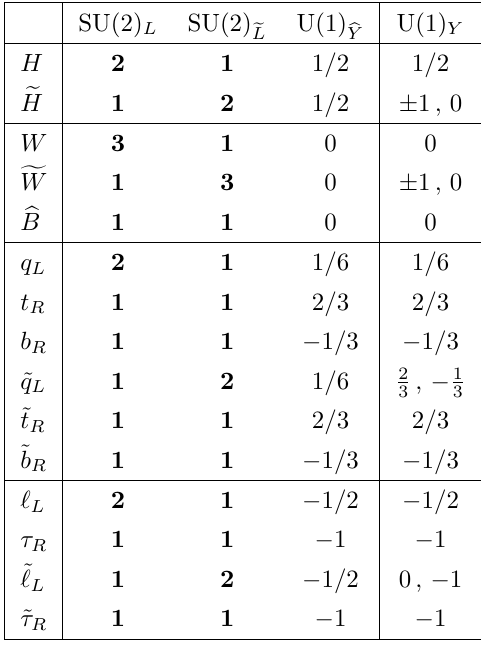
Table 1 . EW gauge quantum numbers of the SM (cid:12)elds and their twins. In the minimal scenario, with no twins for the SM W and Z , only SU(2) L (cid:2) U(1) Y are gauged and the twin low-energy content reduces to ~ t L;R and ~ ! (cid:6) ; 0 (cid:26) H e